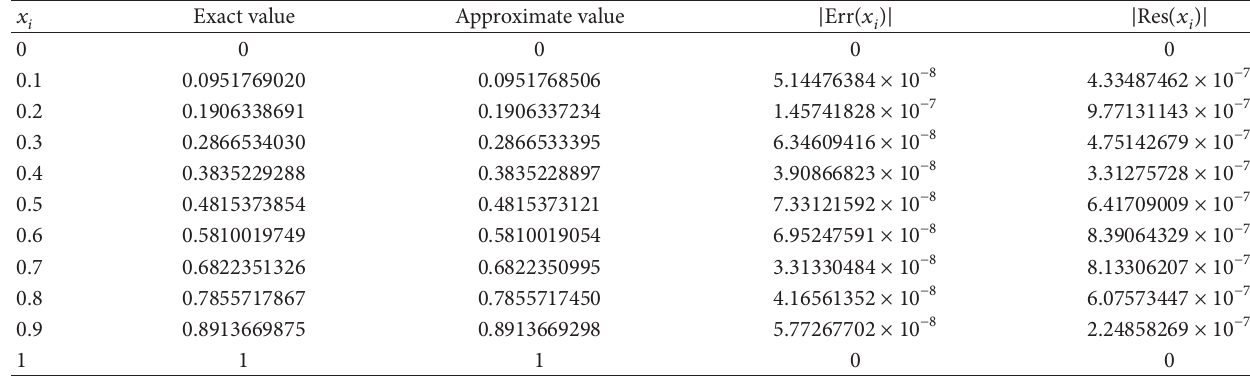
Table 1: Numerical results for Troesch’s problem when 𝜆 = 0.5 .